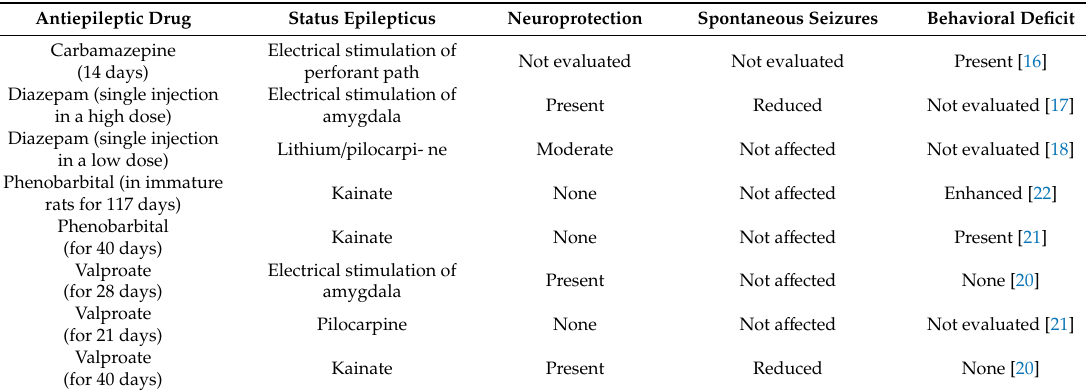
Conventional antiepileptic drugs and their e ff ects of status epilepticus-induced neurodegeneration, spontaneous seizure activity and behavioral deficit in